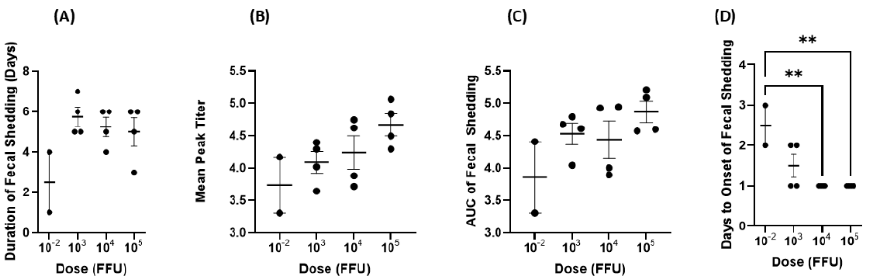
Figure 5. Virus shedding from PID 1–7 after inoculation of Gn pigs with different doses of Arg HRV. ( A ) duration of fecal shedding, ( B ) geometric mean peak titer, ( C ) AUC of fecal shedding, and ( D ) onset of fecal shedding. A log(10) transformation of data was performed for the geometric mean peak titer and AUC before graphing. Geometric mean peak titers and AUC of fecal shedding were positively correlated with inoculum doses (r = 1, p = 0.08). Error bars represent SEM. ** p < 0.01 .